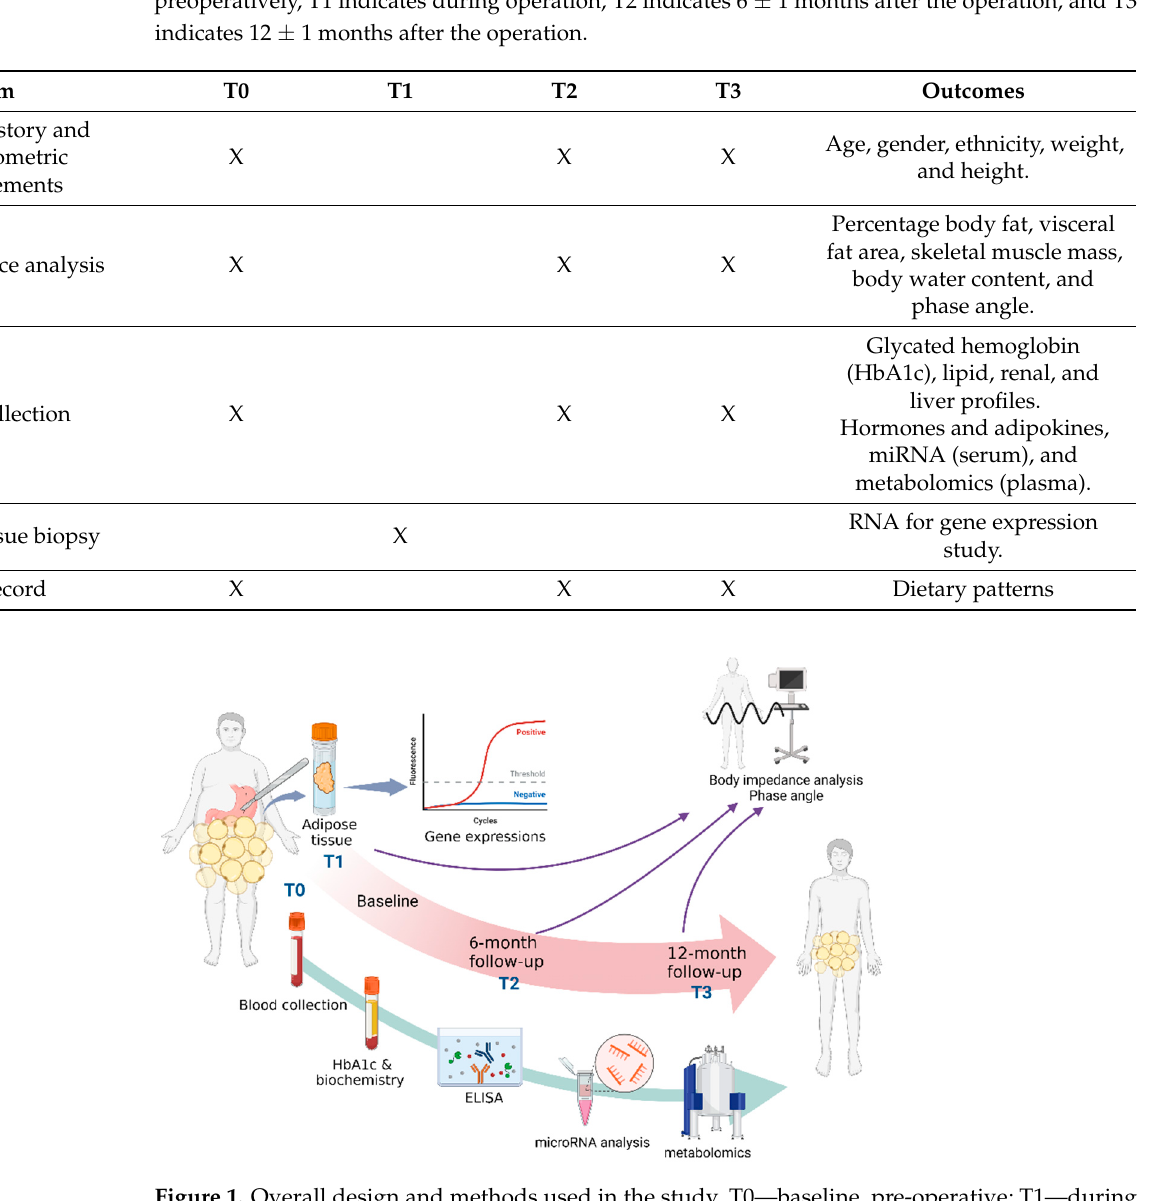
Figure 1. Overall design and methods used in the study. T0—baseline, pre-operative; T1—during surgery; T2—6-month follow-up; T3—12-month follow-up. Created with BioRender.com.